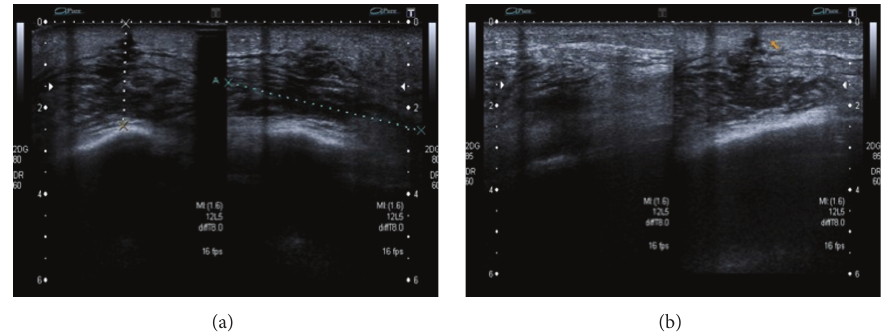
Figure 5: Right thoracic wall ecography. Fluid collection of 17 × 4mm with a fistulous pleural tract with minimal pleural effusion (3.6mm) associated with a small subcutaneous abscess in the area where the pigtail catheter was originally inserted, with the risk of producing a fistula to skin.